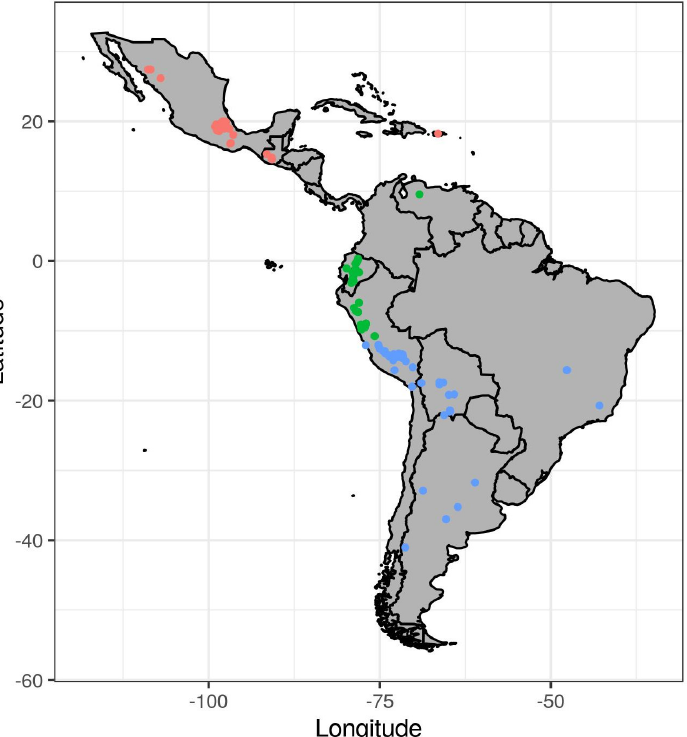
Figure 1. Geographical distribution of the accessions used in the study ( n = 226). Dot colors indicate the categorically determined latitudinal groups of the accessions. Red color indicates Central America group, green color indicates South America-I group and blue color indicates South America-II group.